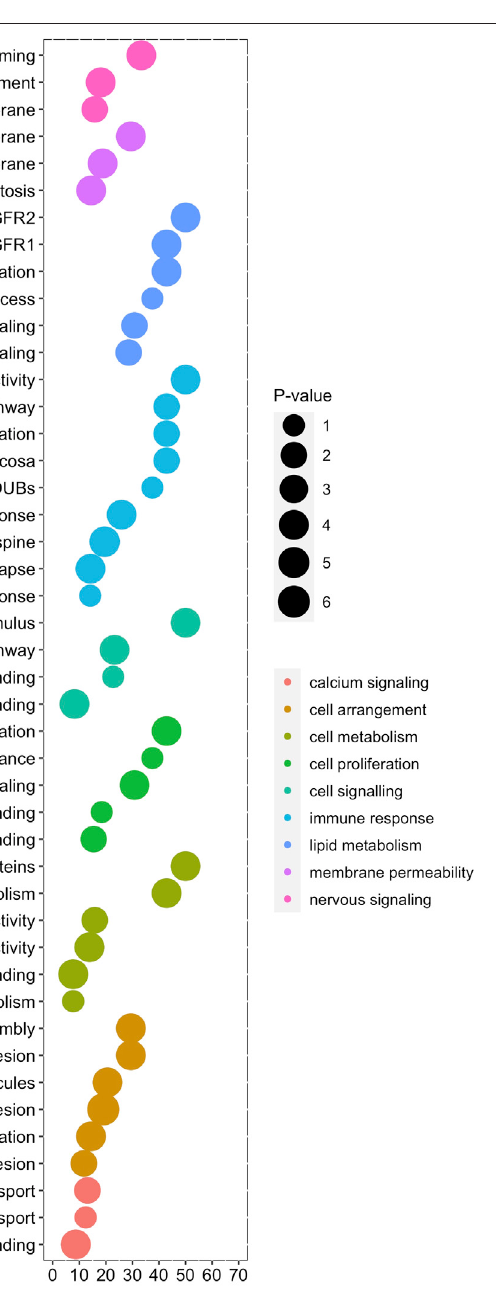
Frontiers in Genetics |